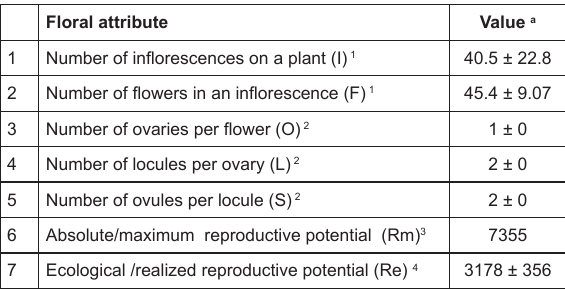
Table 3. Values of different floral attributes of sarpagandha determining its absolute and ecological reproductive